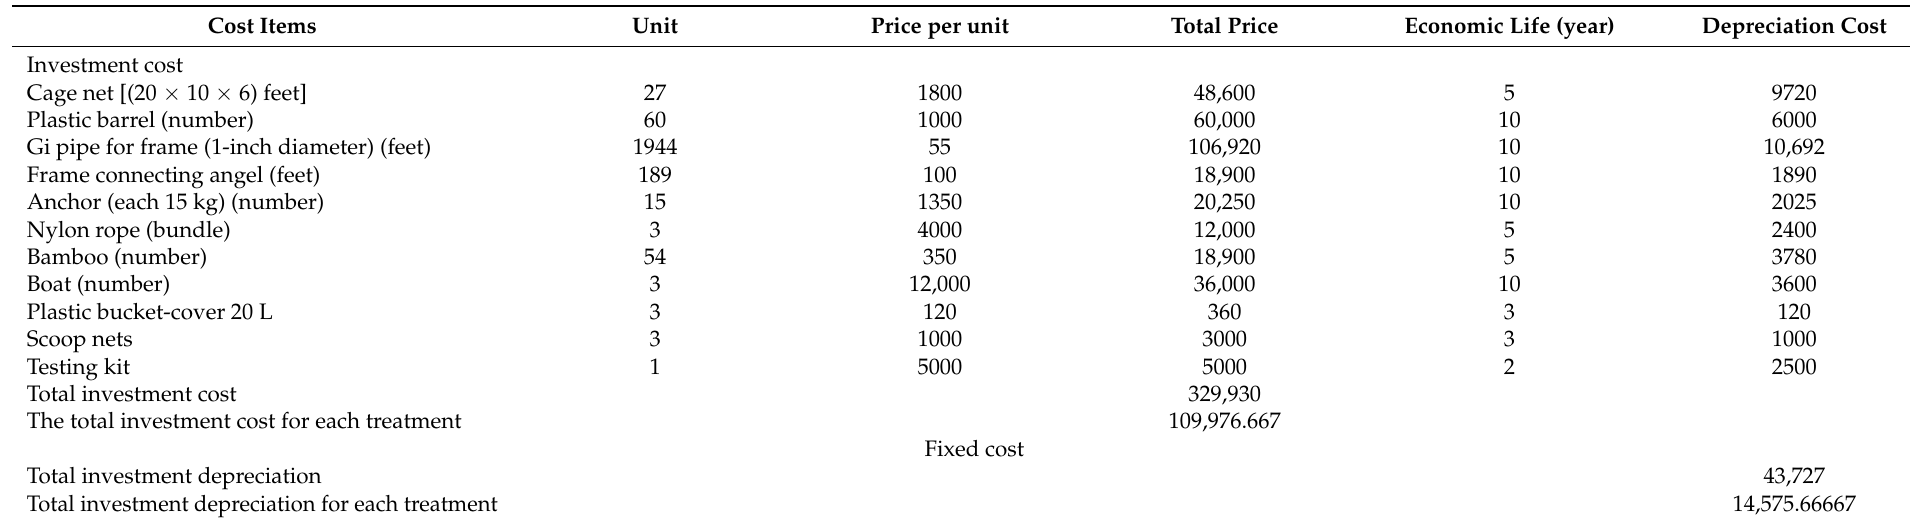
Table 5. Investment cost (BDT) and fixed cost (BDT) of Nile Tilapia ( O. niloticus L.) culture for 120 days under cage-culture